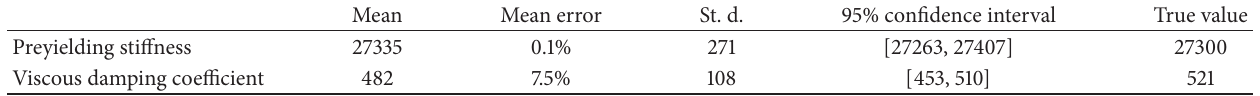
Table 2: Estimations of preyielding stiffness [KN/m] and viscous damping coefficient [KN ⋅ s/m].